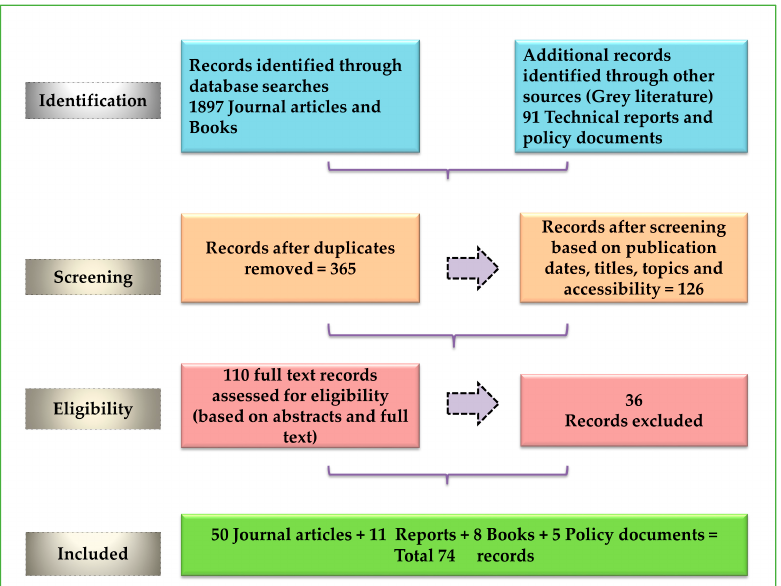
Figure 1. Flowchart of literature search, process and results.